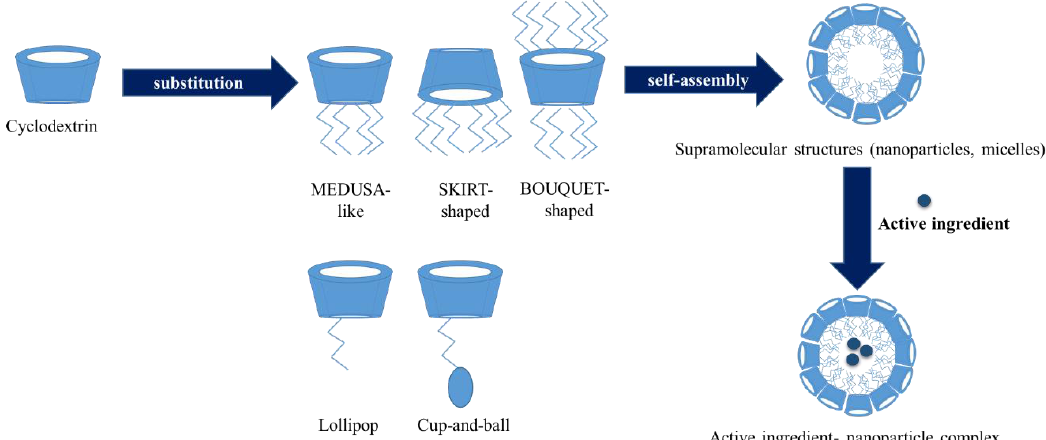
Figure 6. Amphiphilic cyclodextrins: structure, self-association and drug loading .